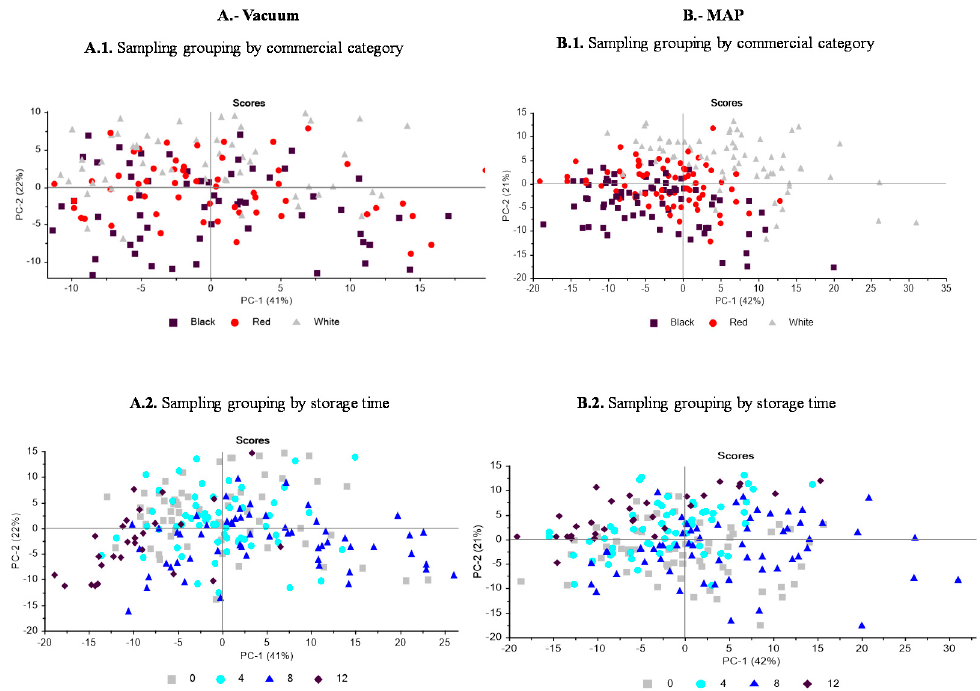
Figure 1. Principal component analyses (PCA) of Iberian dry-cured ham from three commercial categories ( Black , Red and White ) and different refrigerated (4 °C) storage time (T0, T4, T8 and T12) packed under: vacuum (A); and modified atmosphere (MAP) (70% O 2 :30% CO 2 ). ( A ). PCA for vacuum packaging, using α - and γ -tocopherols, ( − ) C16:0, ( − ) C18:0 and C18:1 n-9 (PC1) and L*, C18:2 n-6 and C18:3 n-3 (PC2). ( B ). PCA of MAP, using ( − ) α and ( − ) γ -tocopherols, C16:0, C18:0 and ( − ) C18:1 n-9 (PC1) and ( − ) C18:2 n-6 and ( − ) C18:3 n-3 (PC2). Sampling grouping by commercial category is shown in ( A.1 , B.1 ): Black , Red and White are presented as black, red and grey markers, respectively. It is shown by storage time in ( A.2 , B.2 ): T0, T4, T8 and T12 are presented as grey, light blue, dark blue and black markers,